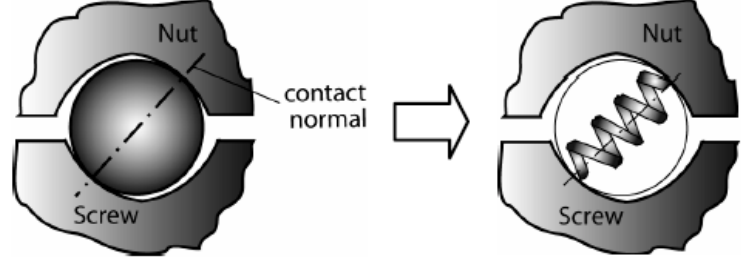
Figure 8. Simplification of rolling element in stiffness model.